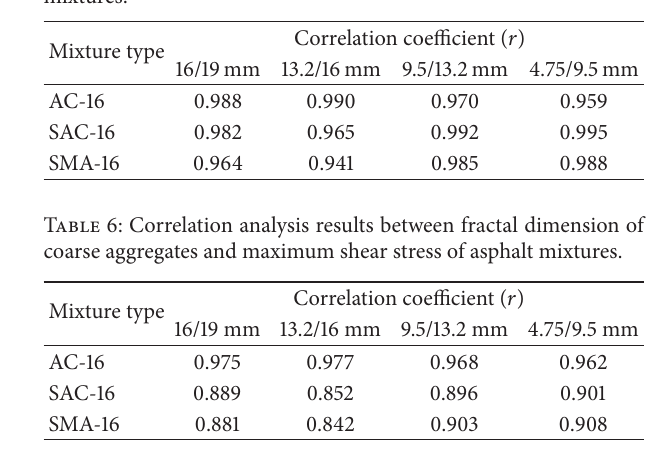
Figure 8: Rutting test results for AC-16, SMA-16, and SAC-16.